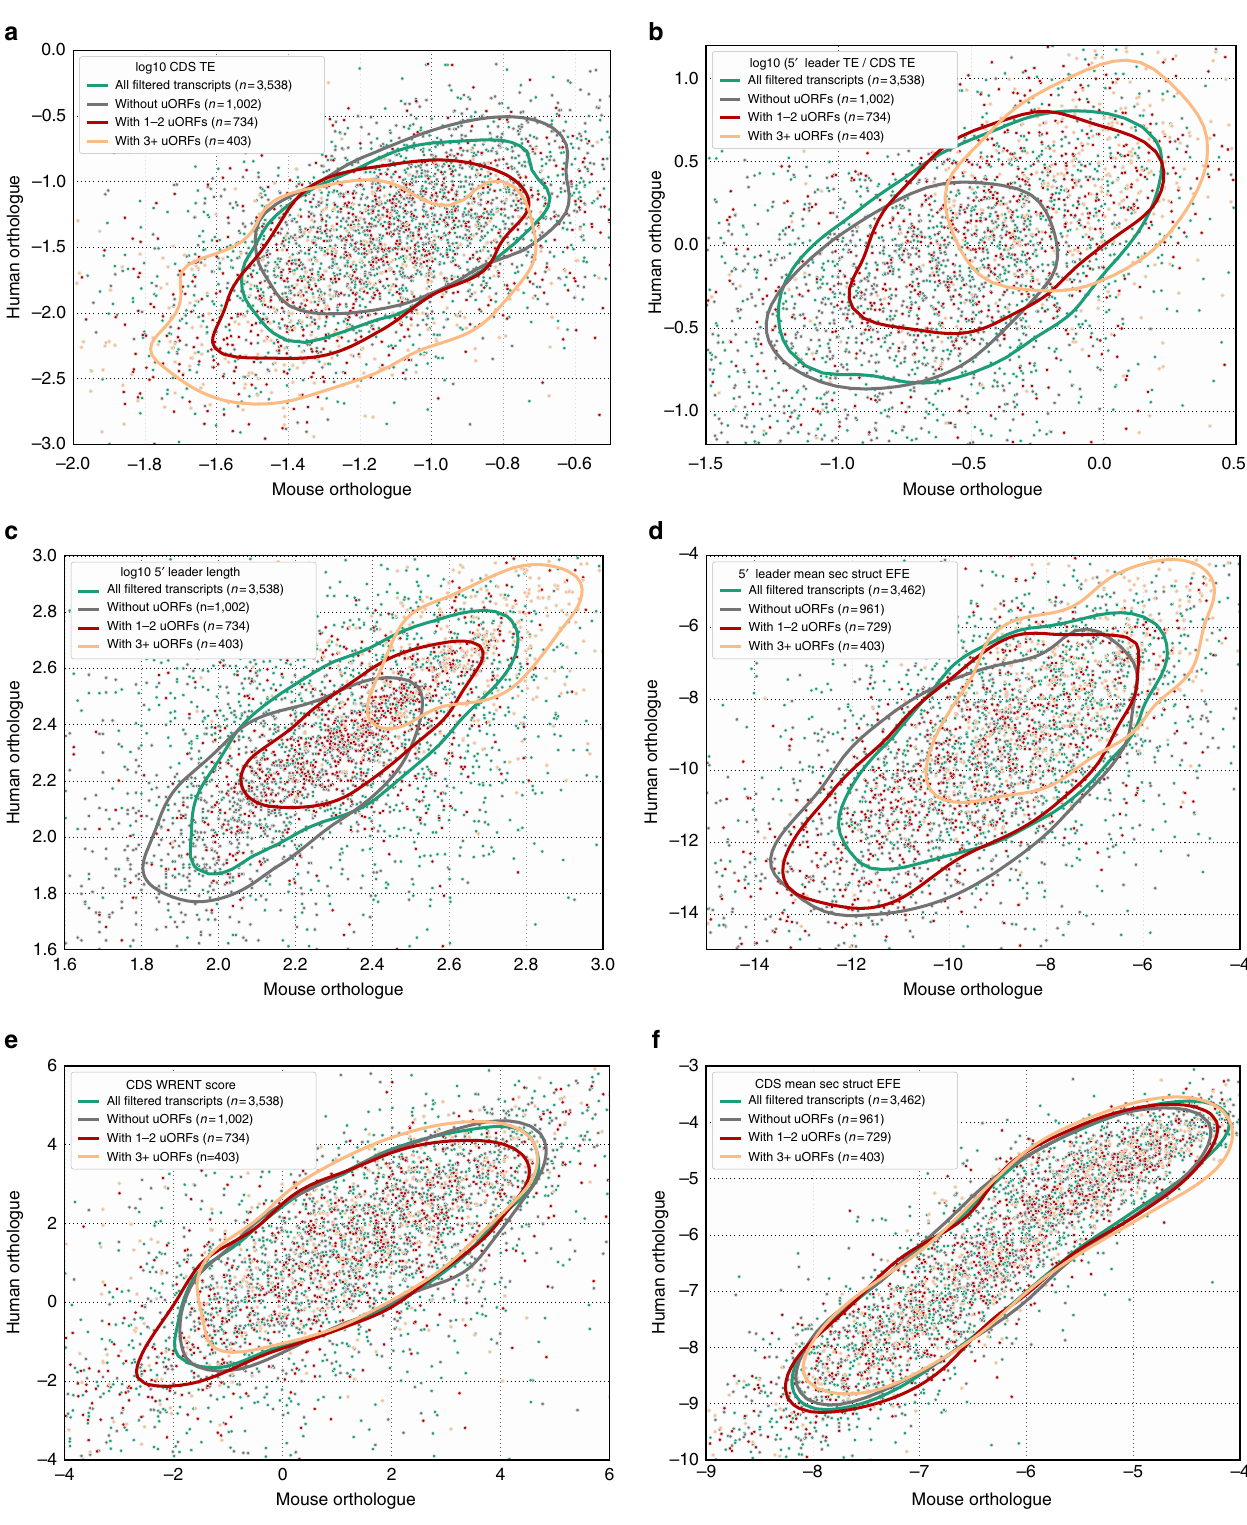
Figure 4 | Translation and sequences features in 5 0 leaders and CDSes are conserved between mouse and human. ( a – f ) Scatter plots of CDS TE ( a ), the ratio of 5 0 leader TE to CDS TE ( b ), 5 0 leader length ( c ), 5 0 leader mean secondary structure EFE ( d ), CDS WRENT score ( e ) and CDS mean secondary structure EFE ( f ), for human and mouse orthologous transcripts. Data points are coloured by the number of uORFs in the orthologous pairs of transcripts, while contours (20th percentile values of a bivariate Gaussian kernal density estimator) depict the distribution of each subset of points. Translation and sequence features in orthologous transcripts are generally well correlated between human and mouse, which is indicative of their conservation; conservation of translation ( a , b ) and 5 0 leader sequence features ( c , d ) additionally co-vary with the number of uORFs in a transcript, while conservation of CDS sequence features is largely independent of uORF number ( e , f